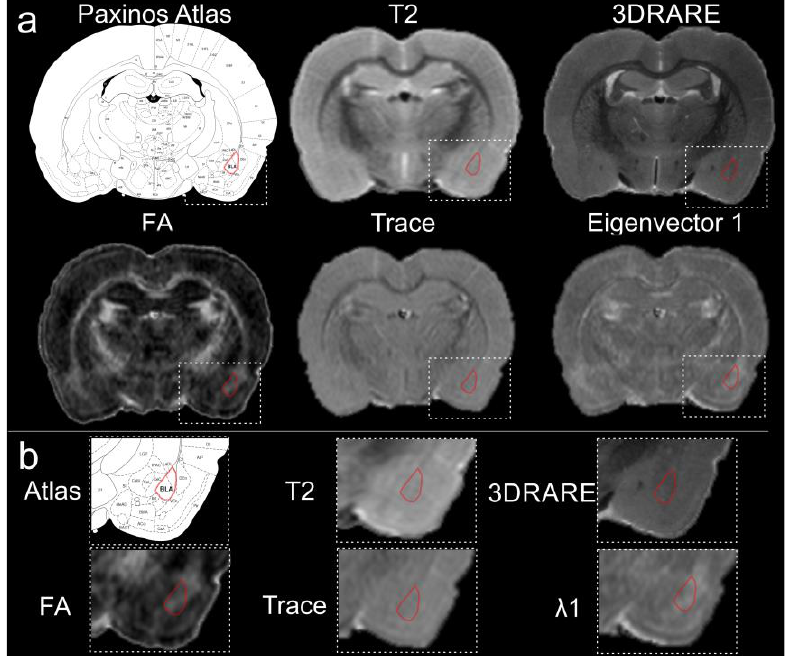
Figure 1. High-resolution magnetic resonance imaging of the rodent brain does not elucidate the boundaries for the basolateral amygdala. ( a ) The basolateral complex of the amygdala is highlighted (red) in several common imaging modalities including T2-weighted imaging, 3DRARE (3D rapid acquisition with relaxation enhancement) and diffusion tensor imaging parametric maps, including fractional anisotropy (FA), trace and eigenvalue λ1. The anatomical boundaries of the BLA on the MR images were created by referencing the Paxinos Atlas. ( b ) Expanded images from the MR images in ( a ), further illustrates the difficulty in identifying the anatomical boundaries of the BLA. All images were collected from the same animal at 11.7